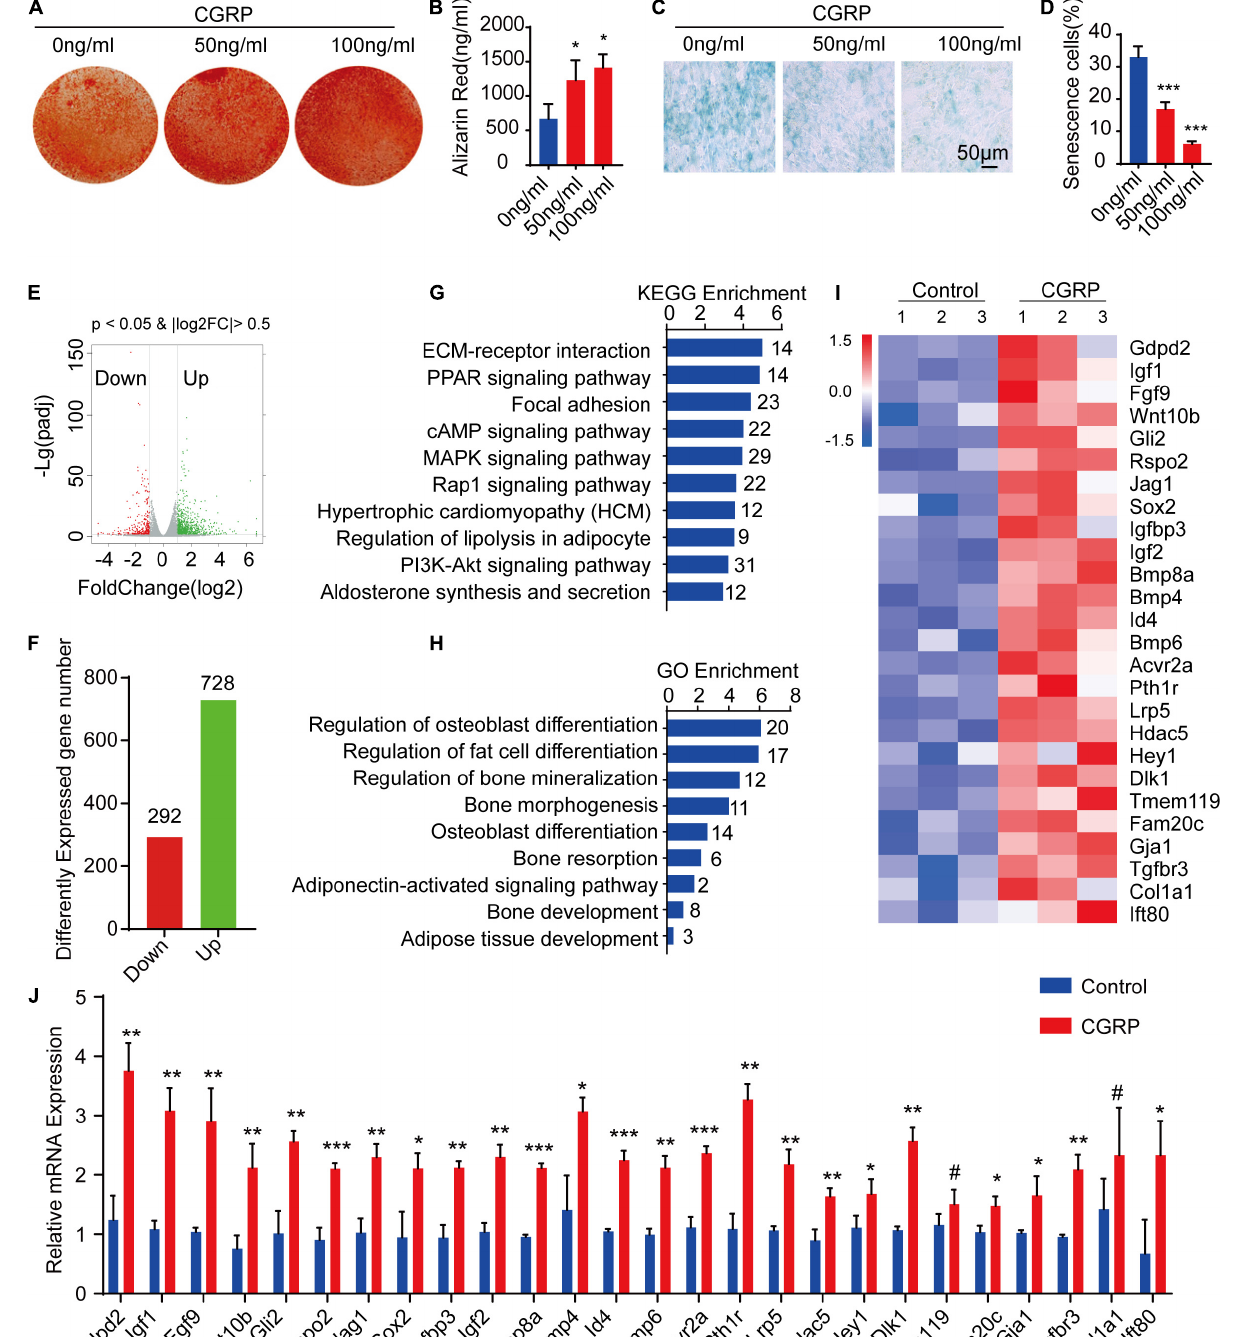
Frontiers in Cell and Developmental Biology |